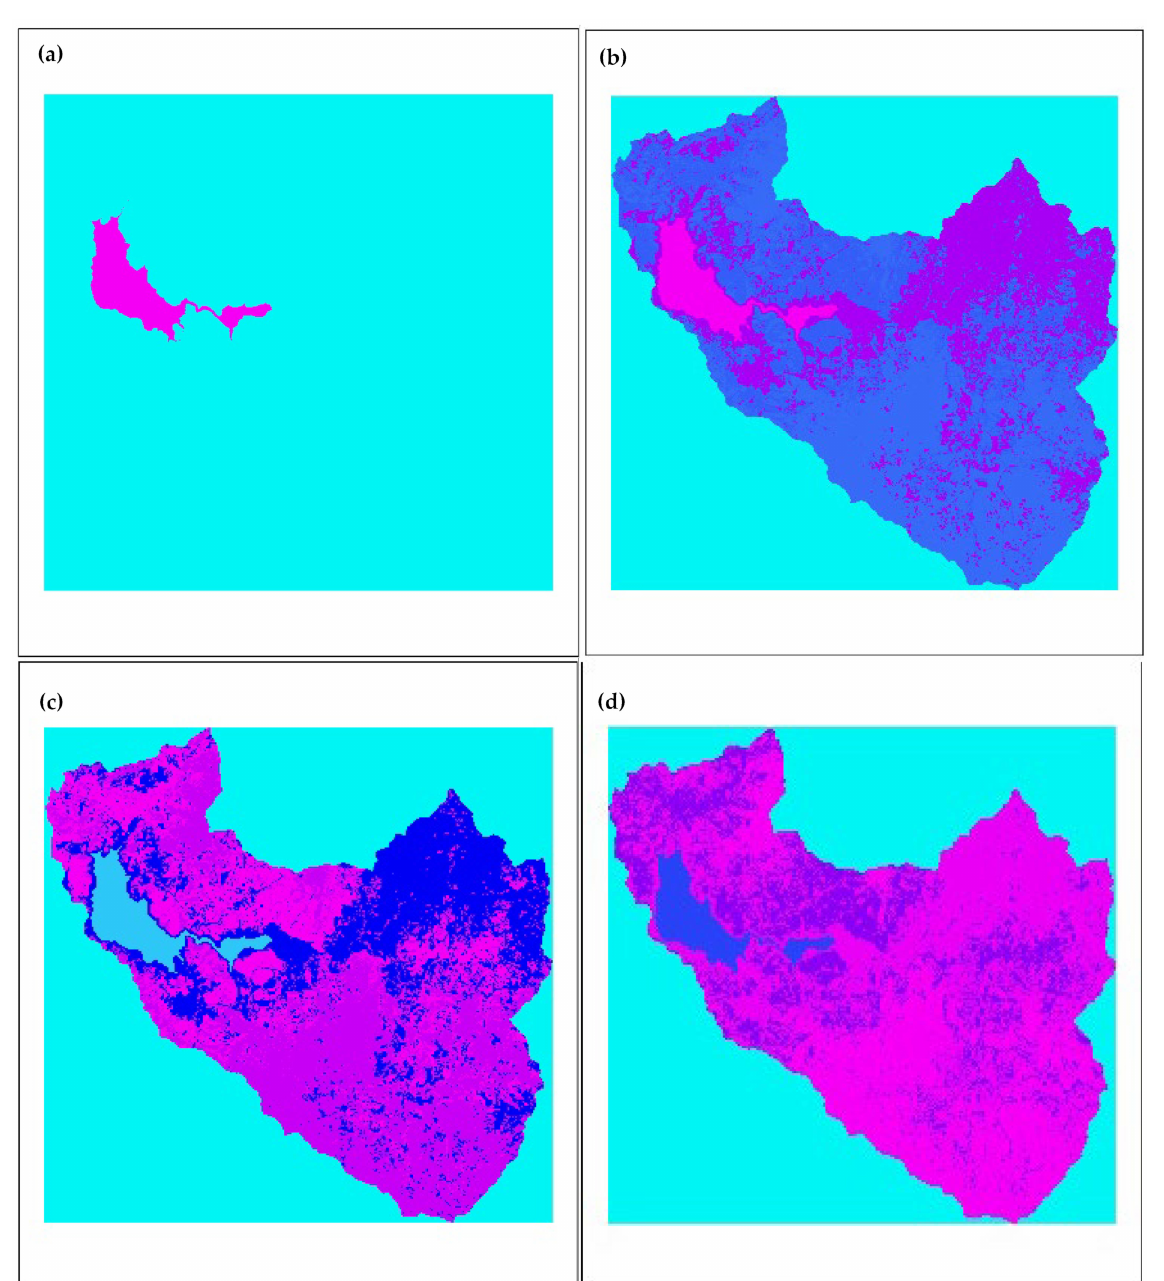
Figure A3. ( a ) Waterbody “land suitability” for the year 2050; ( b ) Bareland “land suitability” for the year 2050; ( c ) Forest “land suitability” for the year 2050; ( d ) Agricultural “land suitability” for the year